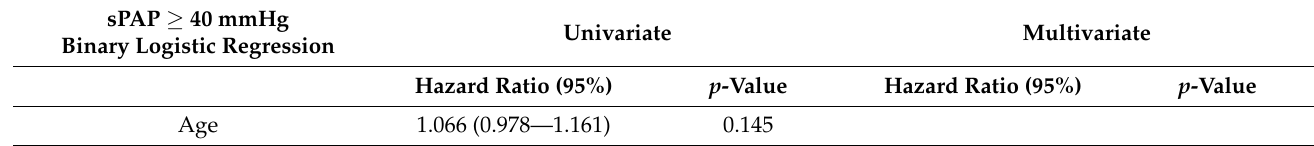
Table 3. Univariate and multivariate binary logistic regression analysis detecting predictors of PH via sPAP ≥ 40 mmHg. sPAP: systolic pulmonary artery pressure; BMI: body mass index; CVD: cardiovas- cular disease; PAD: peripheral artery disease; COPD: chronic obstructive pulmonary disease; LVEF: left ventricular ejection fraction; LVEDD: left ventricular end-diastolic diameter; IVSd: interventricular septal thickness at diastole; AV Vmax: maximal velocity over aortic valve; AV dpmean: mean pressure gradient over aortic valve; AV dpmax: maximal pressure gradient over aortic valve; TAPSE: tricuspid annular plane systolic excursion; AVI: aortic valve insufficiency; MVI: mitral valve insufficiency; TVI: tricuspid valve insufficiency; BNP: brain natriuretic peptide; cTni: cardiac troponin; Hkt: hematocrit; Hb: hemoglobin; CK: creatine kinase; sST2: soluble suppression of tumorigenicity-2; GDF-15: growth differentiation factor-15; H-FABP: heart-type fatty acid binding protein; IGF-BP2: insulin-like growth factor binding protein 2; suPAR: soluble urokinase-type plasminogen activator receptor. Bold numbers: p ≤